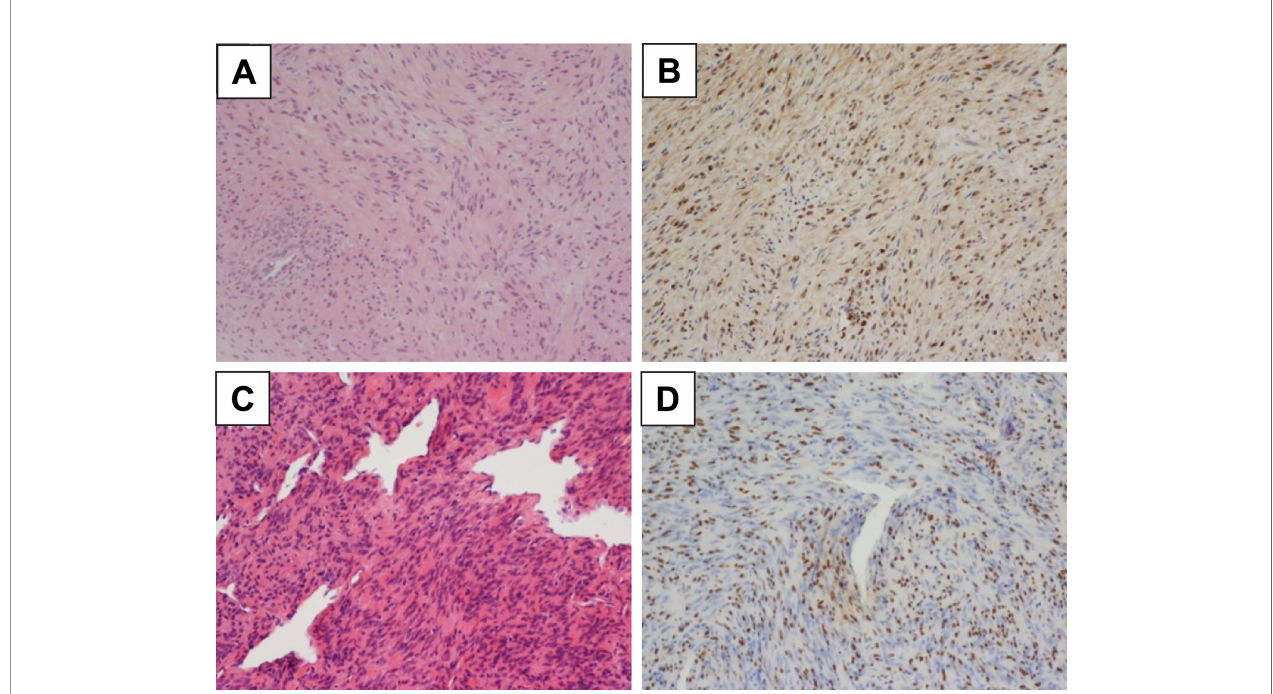
FIGURE 3 | Microscopic Examination of the Histopathological Specimen. (A) The bilateral adrenal tumors are composed of intersecting fascicles of spindle cells, with abundant eosinophilic cytoplasm and elongated nuclei and a hemangiopericytoma-like pattern. (200X HE stain) (B) Epstein-Barr virus-encoded RNA is detected by in situ hybridization in the adrenal tumor. (200X) (C) The extradural tumor is also composed of intersecting fascicles of spindle cells and branching vessels. Morphological features are similar to those of the adrenal tumor. (200X HE stain) (D) Epstein-Barr virus-encoded RNA is additionally detected by in situ hybridization in the extradural tumor (200X).